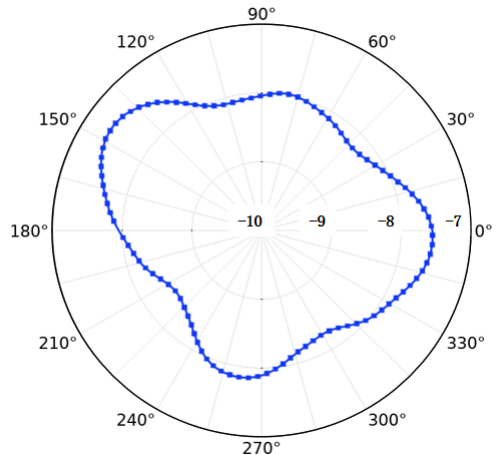
Figure 11. Control of the wellbore temperature of − 216 m sandy clay during excavation.